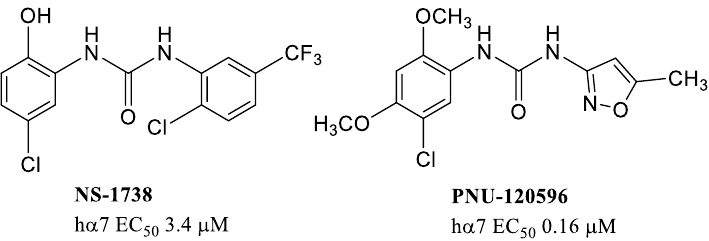
Figure 4. Allosteric modulators with an ureidic function.